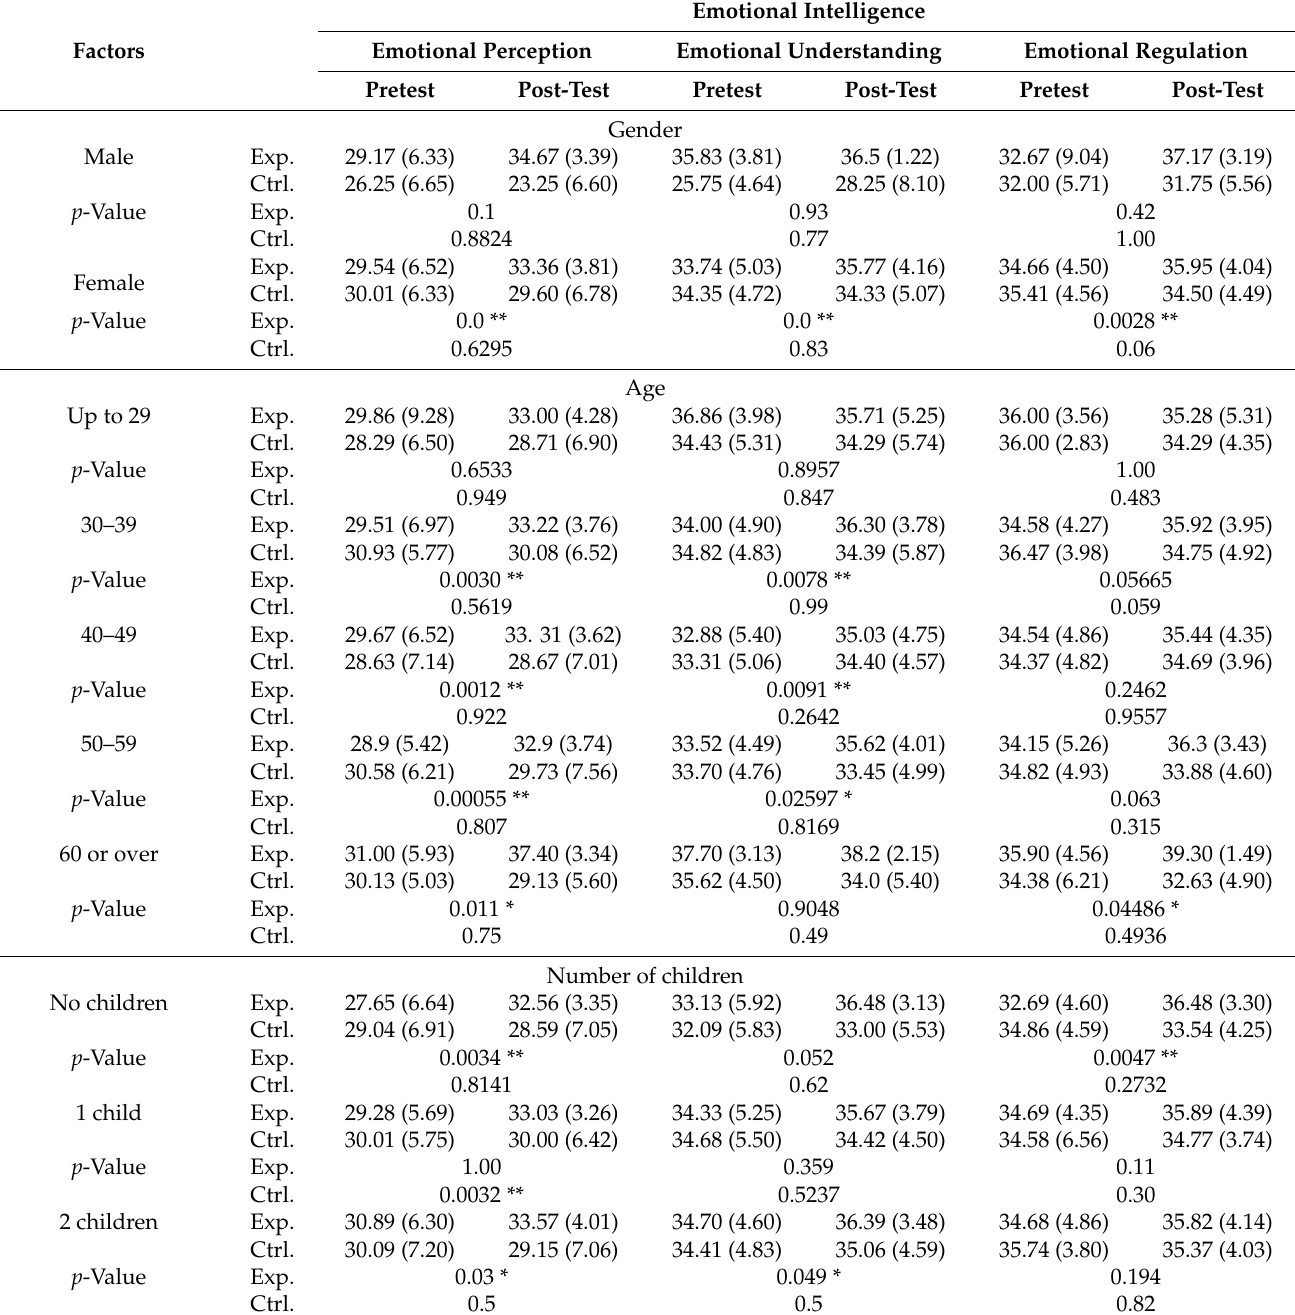
Table 3. Influence of the variables that make up the sociodemographic profile in emotional intelligence in the control group and in the experimental group from pretest and post-test